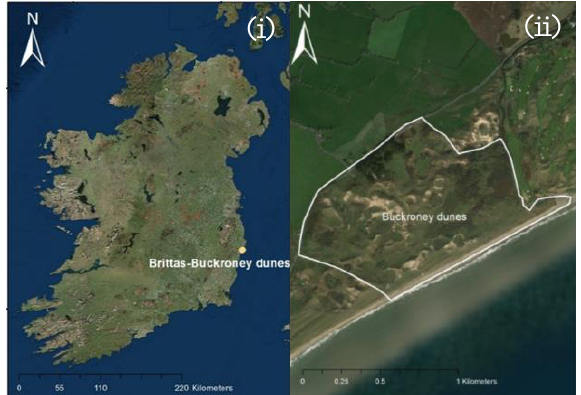
Figure 1. Study site (i) general location and (ii) site details. Within this site, ten habitats listed on the EU Habitats Directive are present, including two priority habitats in Ireland, viz. fixed dune and decalcified dune heath (NPWS, 2013). This dune system also contains good examples of different dune types. At